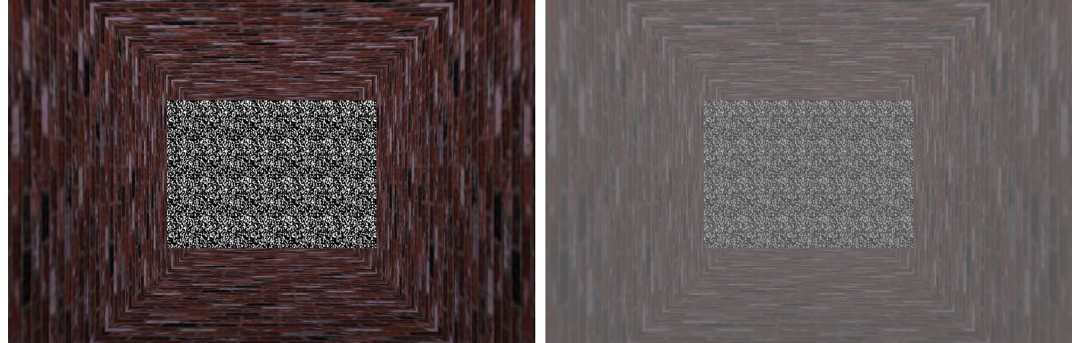
Figure 1. Example stimuli from the noise condition, with full contrast (left) and reduced contrast (right). Contrast reduction corresponded to a transparency of Simulated visual impairments. Participants wore an optometrist’s trial frame, into which lenses with differ- ent filters and of different dioptric values could be inserted. We used lenses with + 1.5 and + 3 diopters, which resulted in a blur of vision. Those lenses are equivalent to an uncorrected myopia of 1 and 2.5 diopters, respec- tively (since 0.5 diopters of accommodation are needed for clear vision at the viewing distance of 2 m). Lenses with 0 diopters served as control condition. In the reduced contrast condition, we used the Vizard software to place a virtual semi-transparent mask (RGB = [216, 216, 216]) with 15% transparency in front of the stimulus, which made the virtual environment appear as if seen through evenly fogged-up glasses. Unfortunately, contrast measures were not taken during data collection. A post-hoc analysis for a different monitor (BenQ PD3200Q) revealed a slight increase of overall luminance by approx. 32 cd/m 2 for the black-white noise-target. The contrast changed from 21.6 to 1.4% in Michelson contrast. Note, however, that these differences were likely reduced for the projector used in the experiment and therefore represent a conservative control. We had previously used